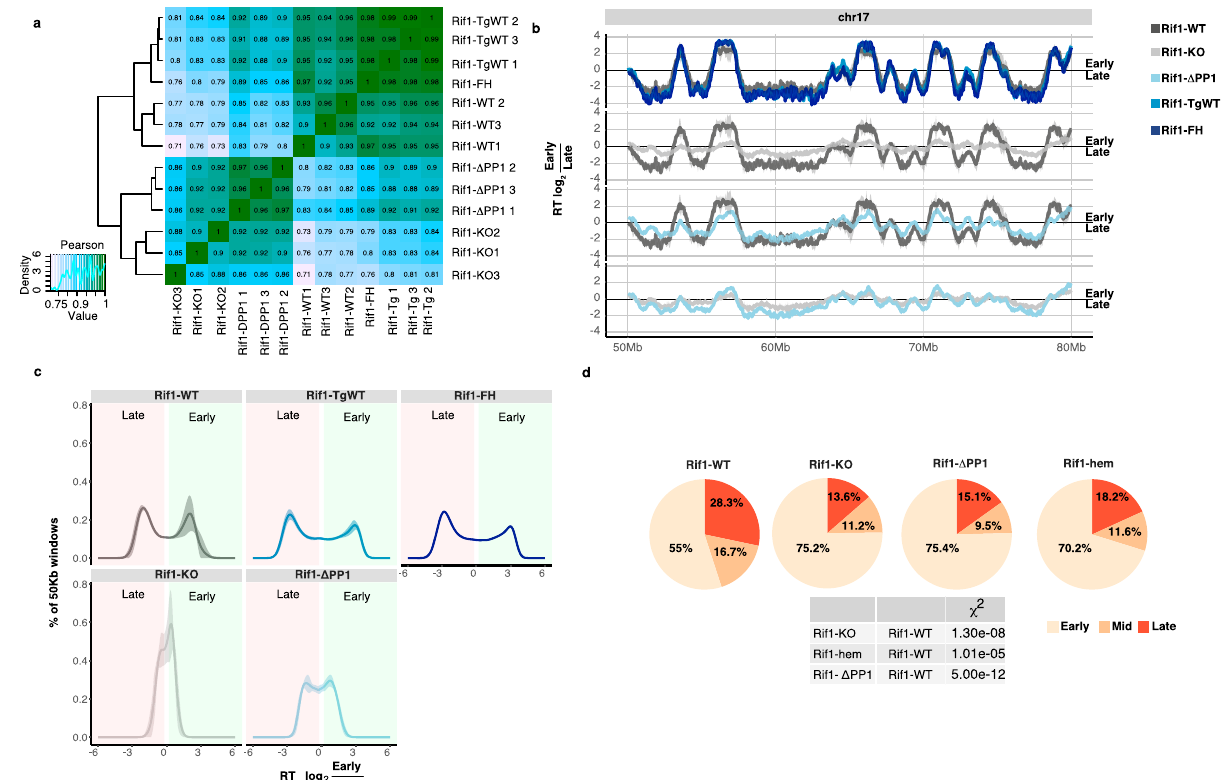
Fig. 2 Effect of loss of RIF1 – PP1 interaction on the replication-timing programme and on the spatial distribution of replication foci. a Hierarchical cluster analysis of Pearson correlation coef fi cient of genome-wide replication-timing (RT) pro fi les between replicas, bin size 50 kb. The analysis shows preferential clustering of RT distribution from Rif1-KO and Rif1- Δ PP1 lines, while RT distribution from Rif1-WT clusters with Rif1-TgWT and Rif1-FH lines . b Representative RT pro fi le from Chromosome 17. The solid line shows the mean of three biological replicas, except for Rif1-FH (single, parental clone). RT scores are calculated as the log 2 of the ratio between mapped reads in the early and late replicating fractions of the cell cycle over bins of 50 kb. c Genome- wide distribution of 50 kb genomic windows on the basis of their RT scores. Mean of three independent lines per genotype is shown, except for Rif1-FH . Shaded areas represent standard deviations. If the mean minus the standard deviation was <0, it was set to 0. RT scores from Rif1-WT and Rif1 hemizygous lines ( Rif1-TgWT and Rif1-FH ) show a bimodal distribution, de fi ning distinct early and late genomic regions. On the contrary, the distribution of RT scores from Rif1-KO lines shows a tendency towards a unimodal distribution, centred around zero. Rif1- Δ PP1 lines display an increase in the windows with RT close to 0, but still a bimodal distribution of the RT values. d The spatial distribution of replication foci (replication patterns) was visualised by EdU and DAPI staining. Cells were pulsed for 30 min with EdU and fi xed. Examples in Fig. S5A. Pie charts show the relative distribution of S-phase cells (EdU positive) between replication patterns corresponding to early, mid, and late S-phase. For each genotype, three independent lines and two separate experiments were blind-scored. As Rif-FH cells are a single cell line with no biological replicas (parental) and the results are very similar to the results from Rif1-TgWT , they were pooled (Rif1-hem). In the table, statistically signi fi cant differences are summarised. P values are calculated by χ 2